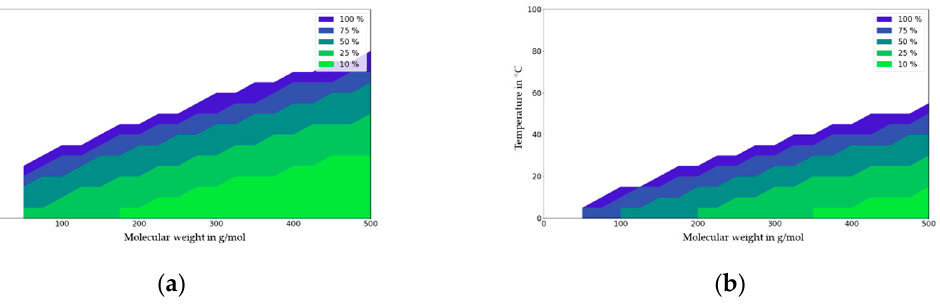
Figure 10. Migration map for PA6 for contact times of 1 day ( a ) and 10 days ( b ). Molecular weight in g/mol against temperature (T) in °C. Deviation of migration in mg/dm 2 independent of partition coefficient (K P,F ) expressed in % at a given initial concentration (1000 mg/kg), material thickness (2000 µm), and area to volume ratio (6 dm 2 per kg food).